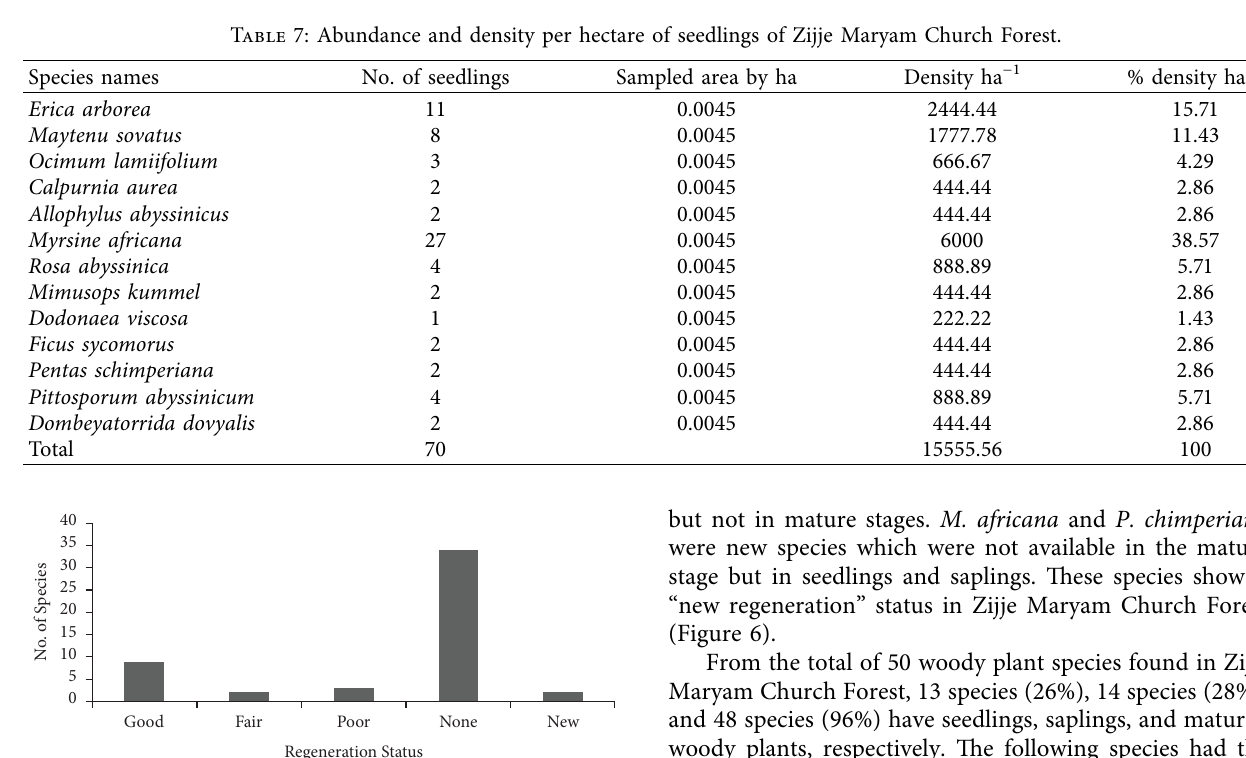
Figure 6: Te regeneration status of Zijje Maryam Church